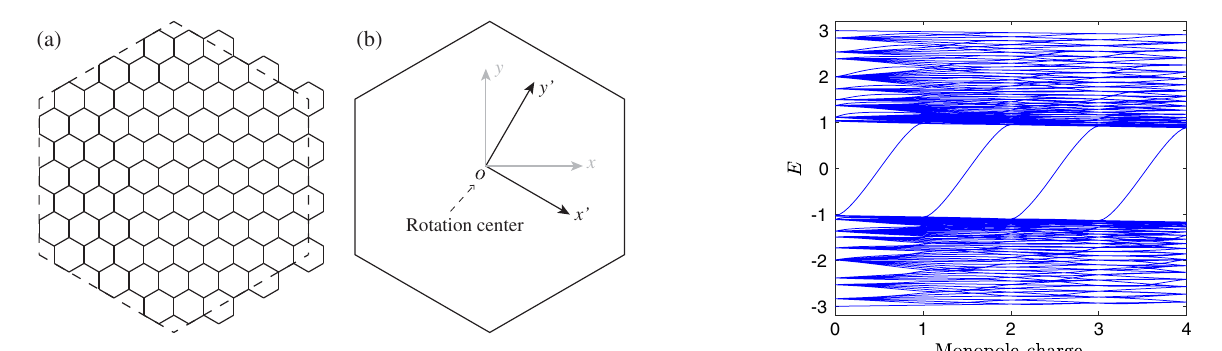
FIG. 9. Torus energy spectrum of the Haldane model at t ¼ 1 , λ ¼ 0 . 2 with respect to the monopole charge Φ = Φ size is set to be N ¼ 3 (81 plaquettes).